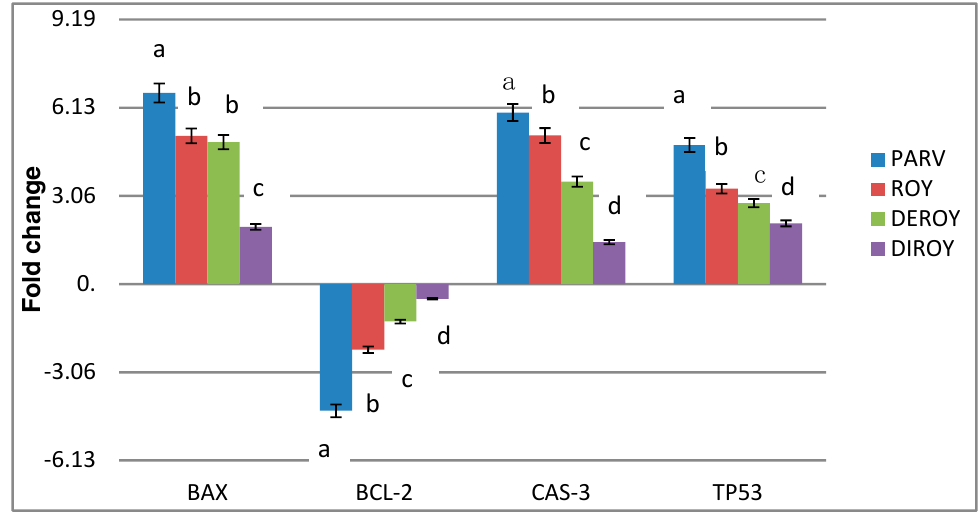
Figure 5. RT-PCR analysis of the mRNA expression of TP53, Cas-3 , Bax, and Bcl-2 in H7AX glioma cells following treatment with Deroy, Diroy, Roy, and Parv D for 24 h. The transcript level of each gene was normalized to the expression of a reference gene ( 18S rRNA ). Data is presented as fold change in cells treated with tested compounds versus untreated, control cells, in which the expression level of the genes was set as 1. The mean values ± SD were calculated from triplicate. The same letter at the same genes are not significantly different at the level of P > 0.05.